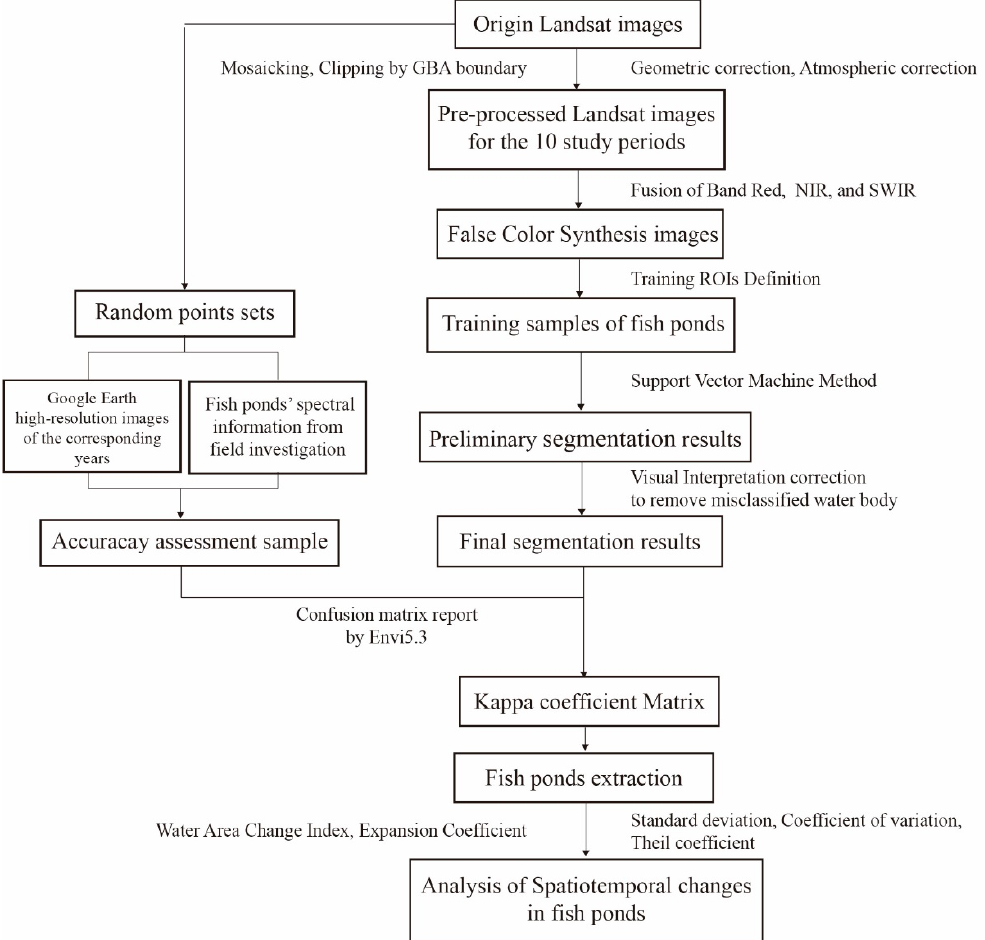
Figure 4. Flowchart for image classification and analysis.